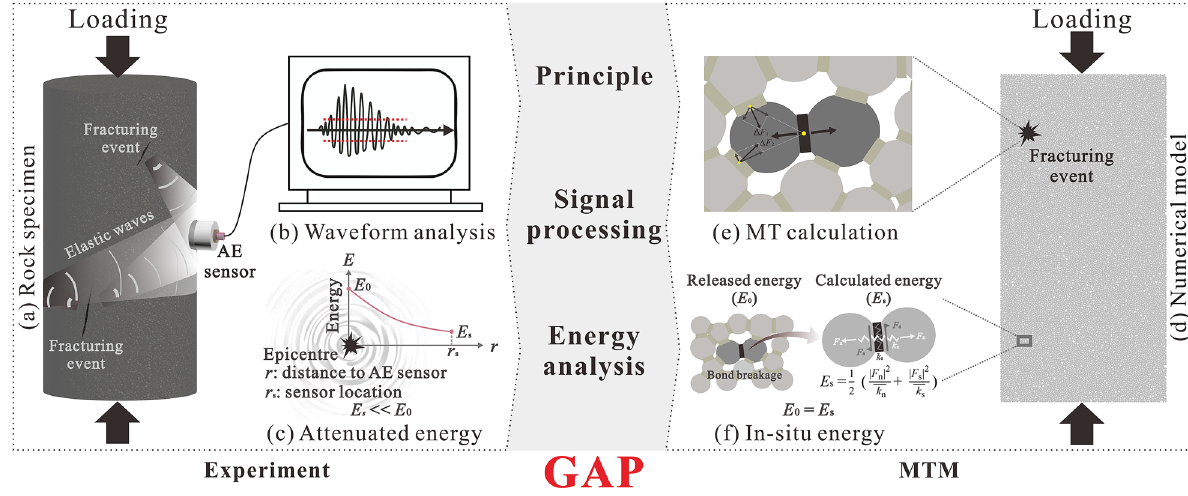
Figure 1. Schematic view of AE characterization by the experiment and